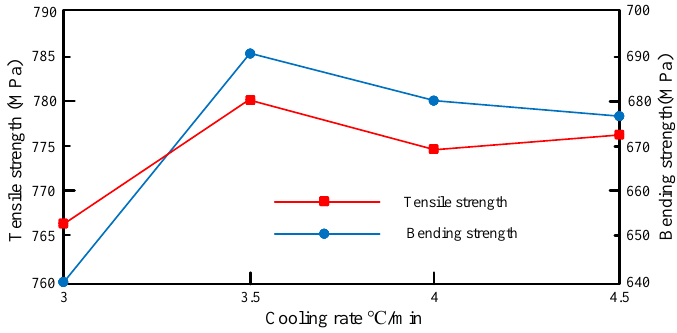
Figure 11. Mapping relationship between cooling rate and mechanical properties.